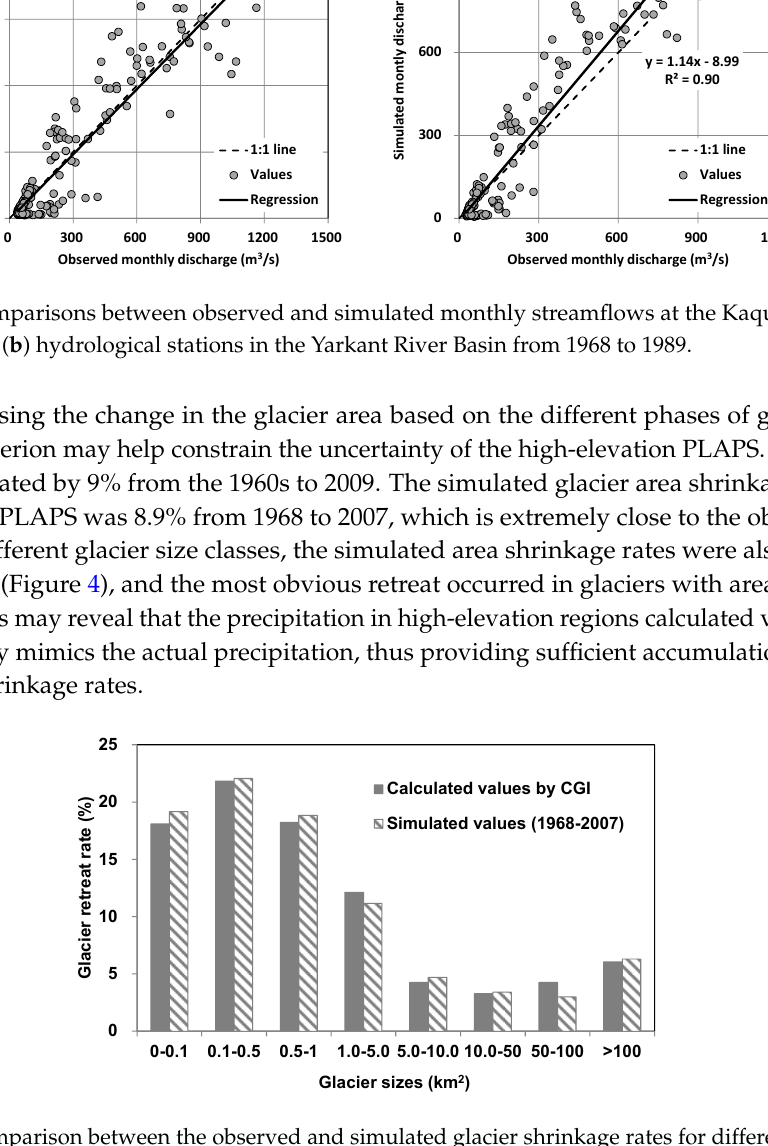
Figure 4. Comparison between the observed and simulated glacier shrinkage rates for different glacier size classes in the Yarkant River basin (CGI stands for the China Glacier Inventory).